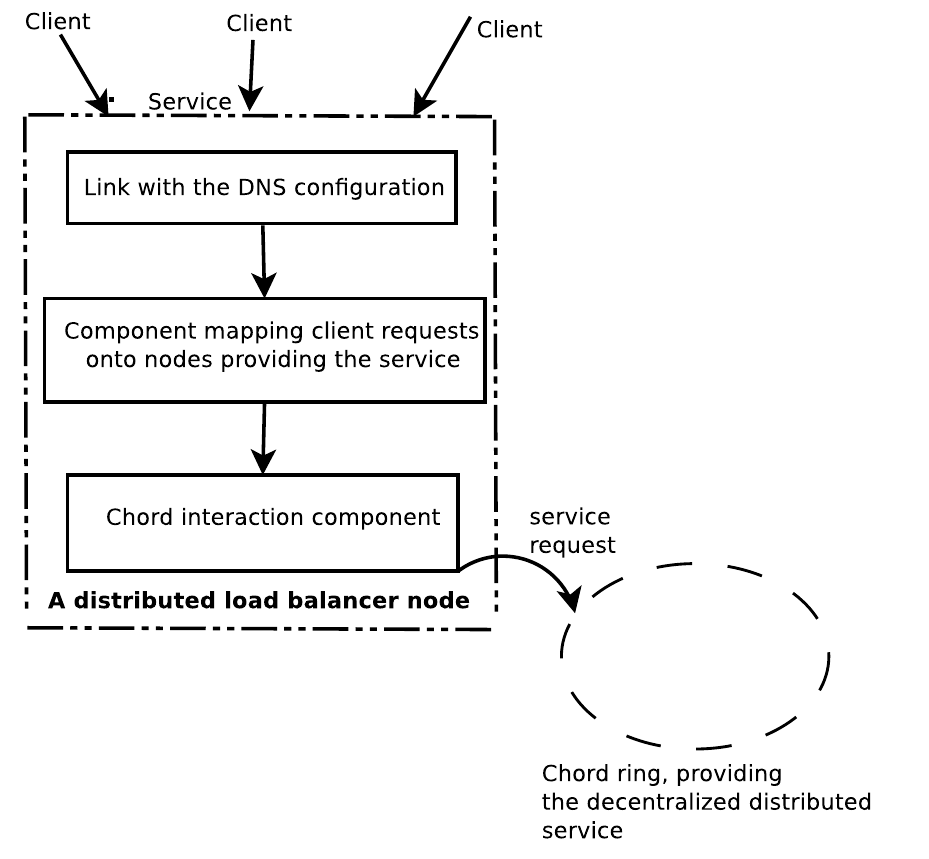
Figure 2. Individual architecture of a load balancing